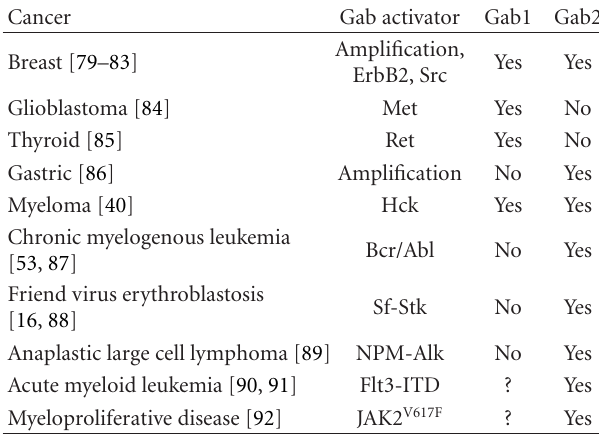
Table 2: Gab1 and Gab2 are activated by kinases, oncoproteins, and other adaptors in cancer